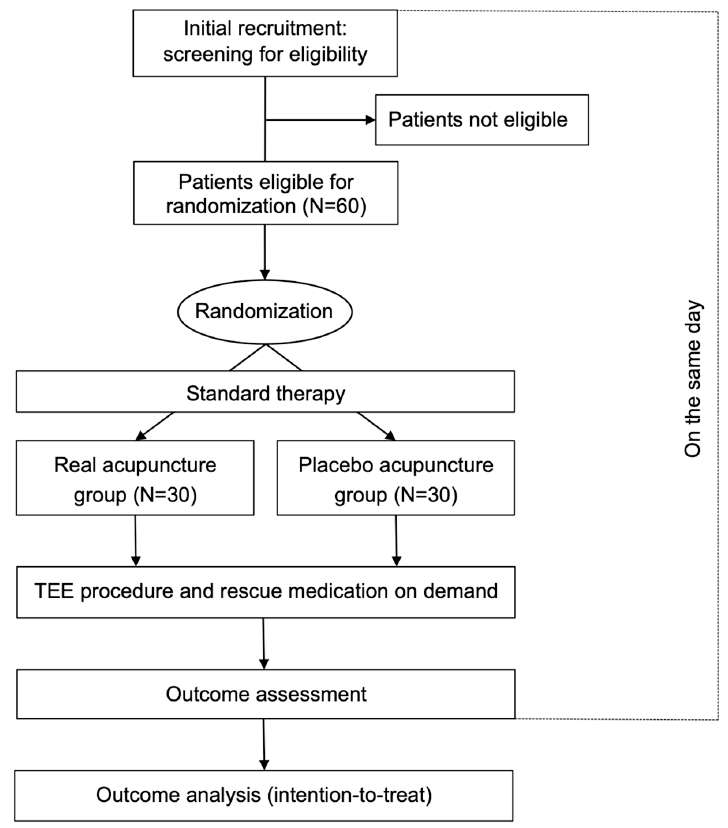
Figure 1. Flow of the investigation. TEE: transoesophageal echocardiography.